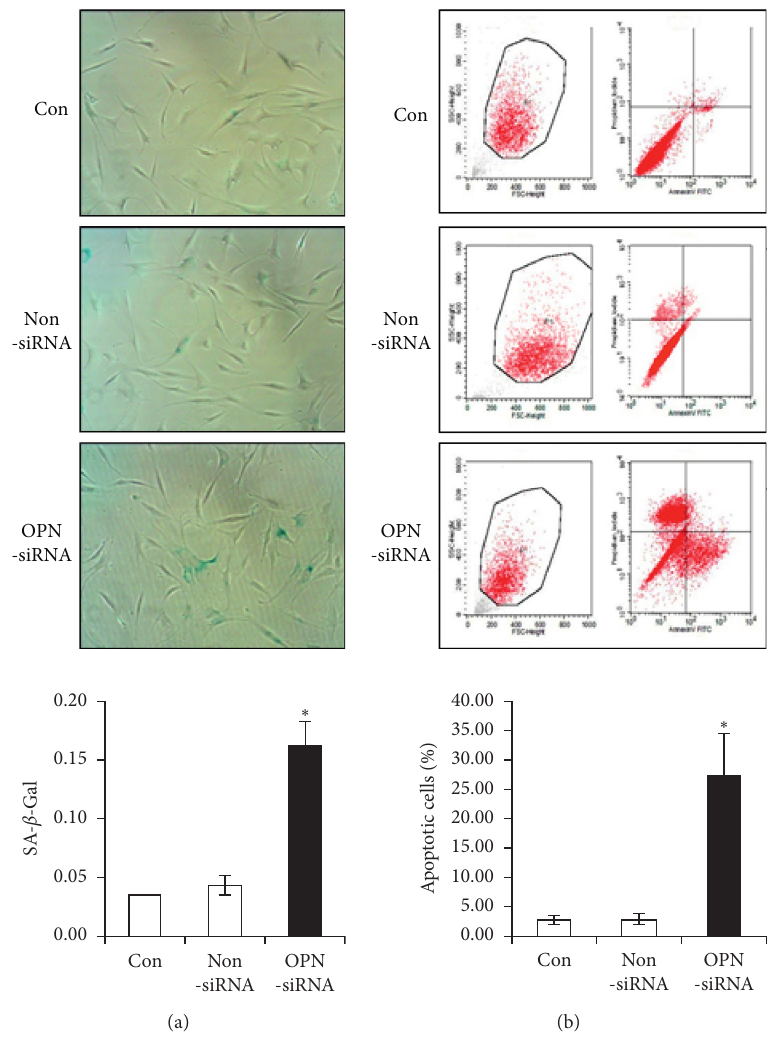
Figure 2: Effects of OPN siRNA on the senescence (a) and apoptosis (b) of OA chondrocytes ( ∗ p < 0 . 05 vs control or